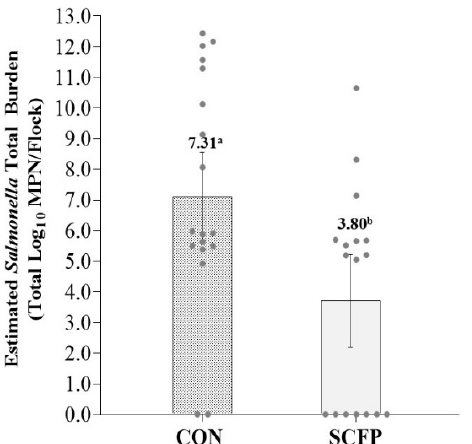
Figure 3. Estimated Salmonella enterica burden by flock within rearing cycle and treatment cohort. Values (MPN/flock) reflect livability-adjusted flock estimates obtained utilizing observed prevalence and load outcomes.